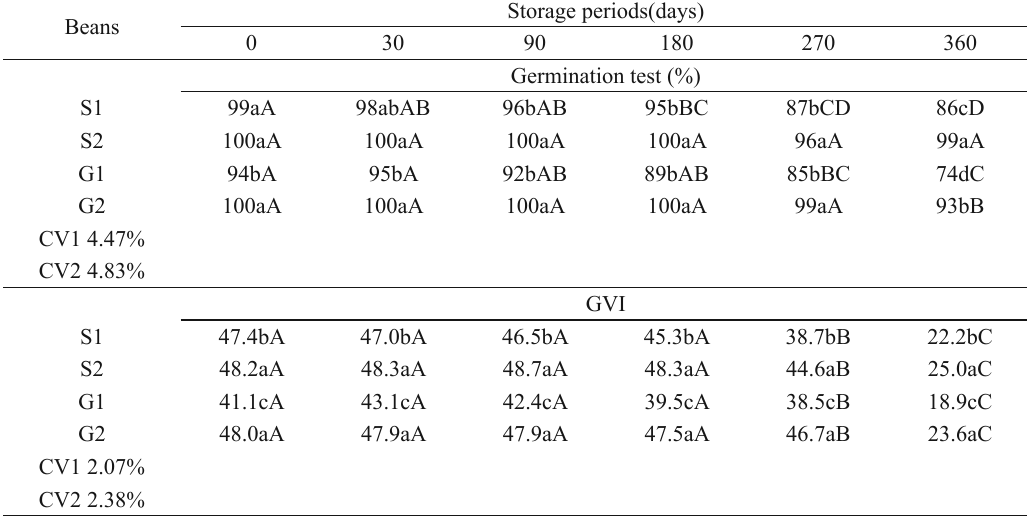
Germination percentage and germination velocity index (GVI) of bean seeds (S) and grains (G), of fi eld 1 and 2, of BRS Splendor variety, during storage periods. Cascavel, PR-2013.